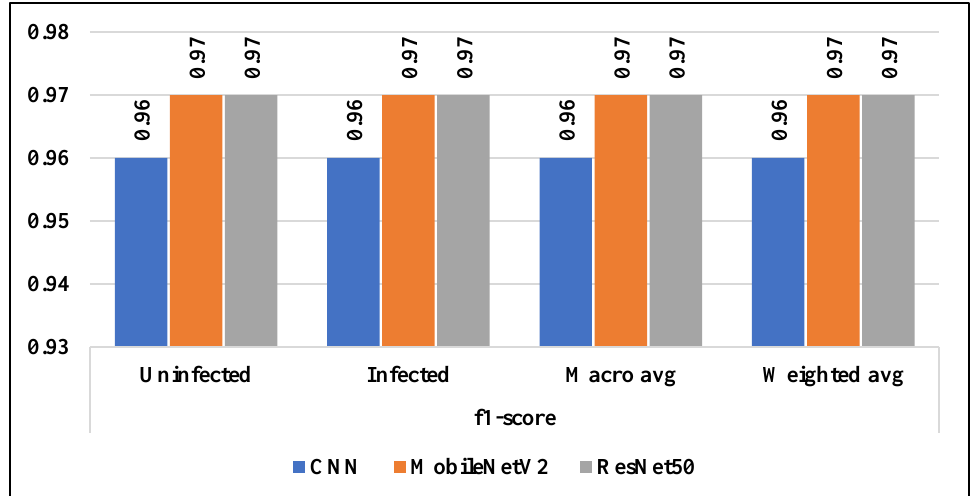
Figure 18. f1-score of all considered models.